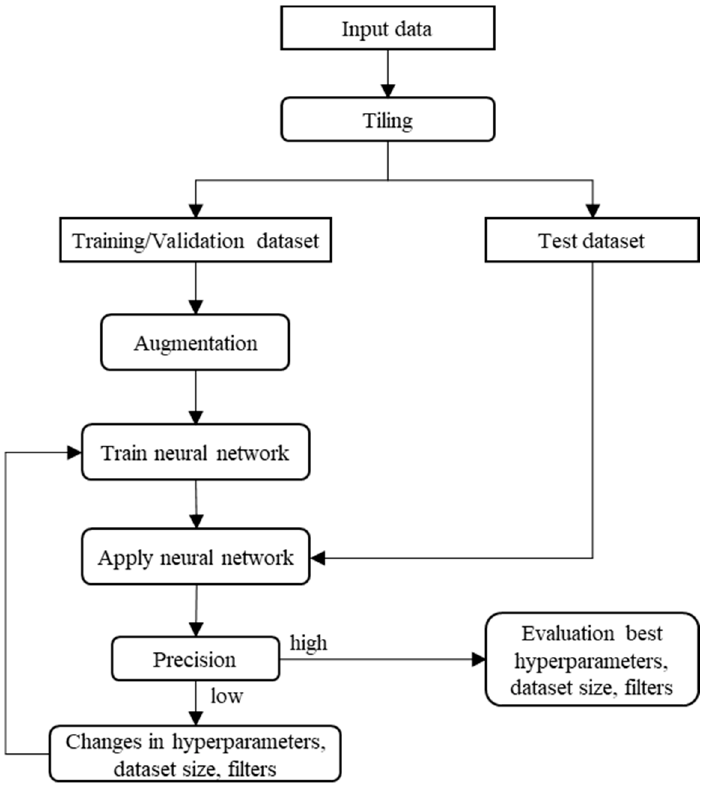
Figure 4. Flow chart summarizing the methodology followed in this study.